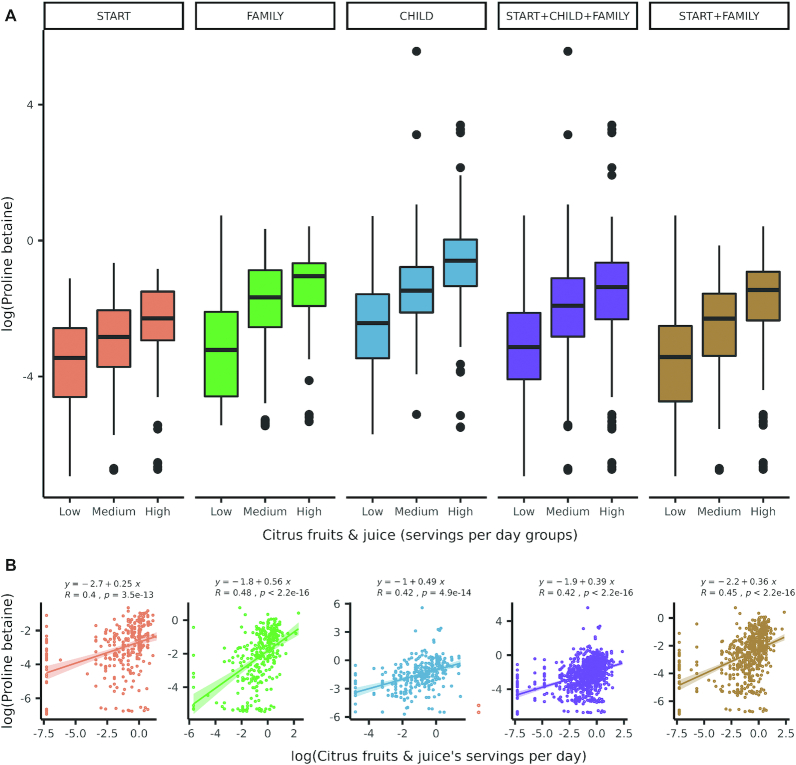
Association of proline betaine with citrus fruits + juice intake by cohort. Panel A shows boxplots of the log(Proline Betaine) by cohort, in all cohorts pooled, and in FAMILY and START (the two studies with the most-similarly measured diet) cohorts only, within people with low, medium, and high daily servings of citrus fruits and juice. Whiskers represent 1.5 x interquartile range; black dots denote oulier points. Panel B shows linear regression equation (top), and Pearson's R ("R") of proline betaine regressed on log(servings/d of citrus fruits + juices, servings/d) by cohort, in all cohorts pooled, and in FAMILY and START. Solid line is line of best-fit; shading respresents 95 confidence limits of the slope of the regression line. CHILD, Canadian Healthy Infant Longitudinal Development study; FAMILY, Family Atherosclerosis Monitoring In earLY life study; START, SouTh Asian biRth cohorT study.